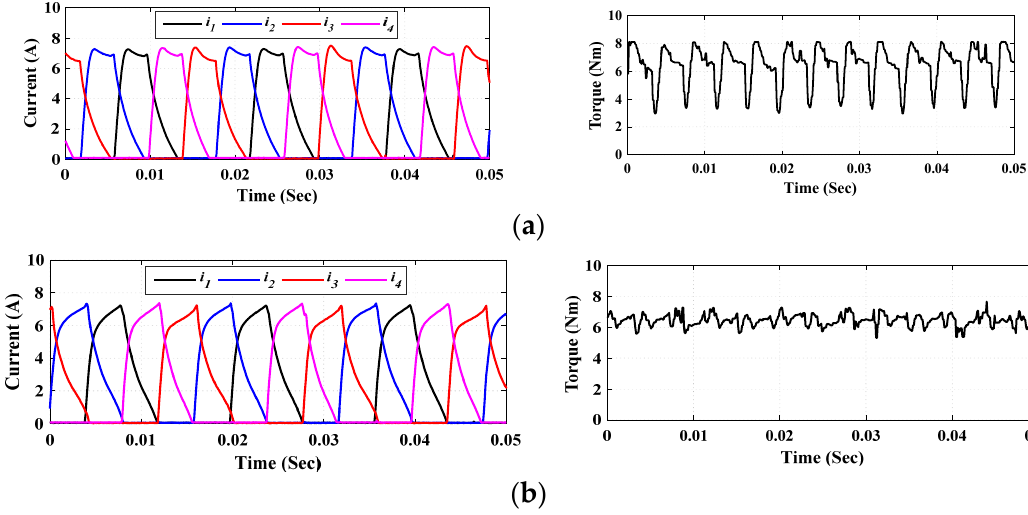
Figure 15. The experimental results at 627 r/min for: ( a ) conventional ATC; ( b ) Proposed SATC.